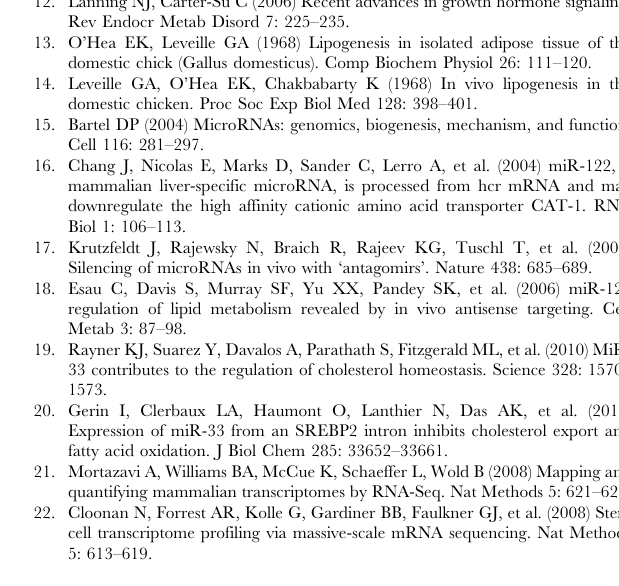
Table S1 Primers for real time RT-PCR. Table S2 Differentially expressed genes by chGH treatment. Table S3 KEGG of differentially expressed genes. Table S4 Identified known chicken miRNAs. Table S5 Identified miRNAs homologous to other species. Table S6 Predicted novel miRNAs. Table S7 Ten most abundant miRNAs. Table S8 Differentially expressed genes related with biosynthetic process.